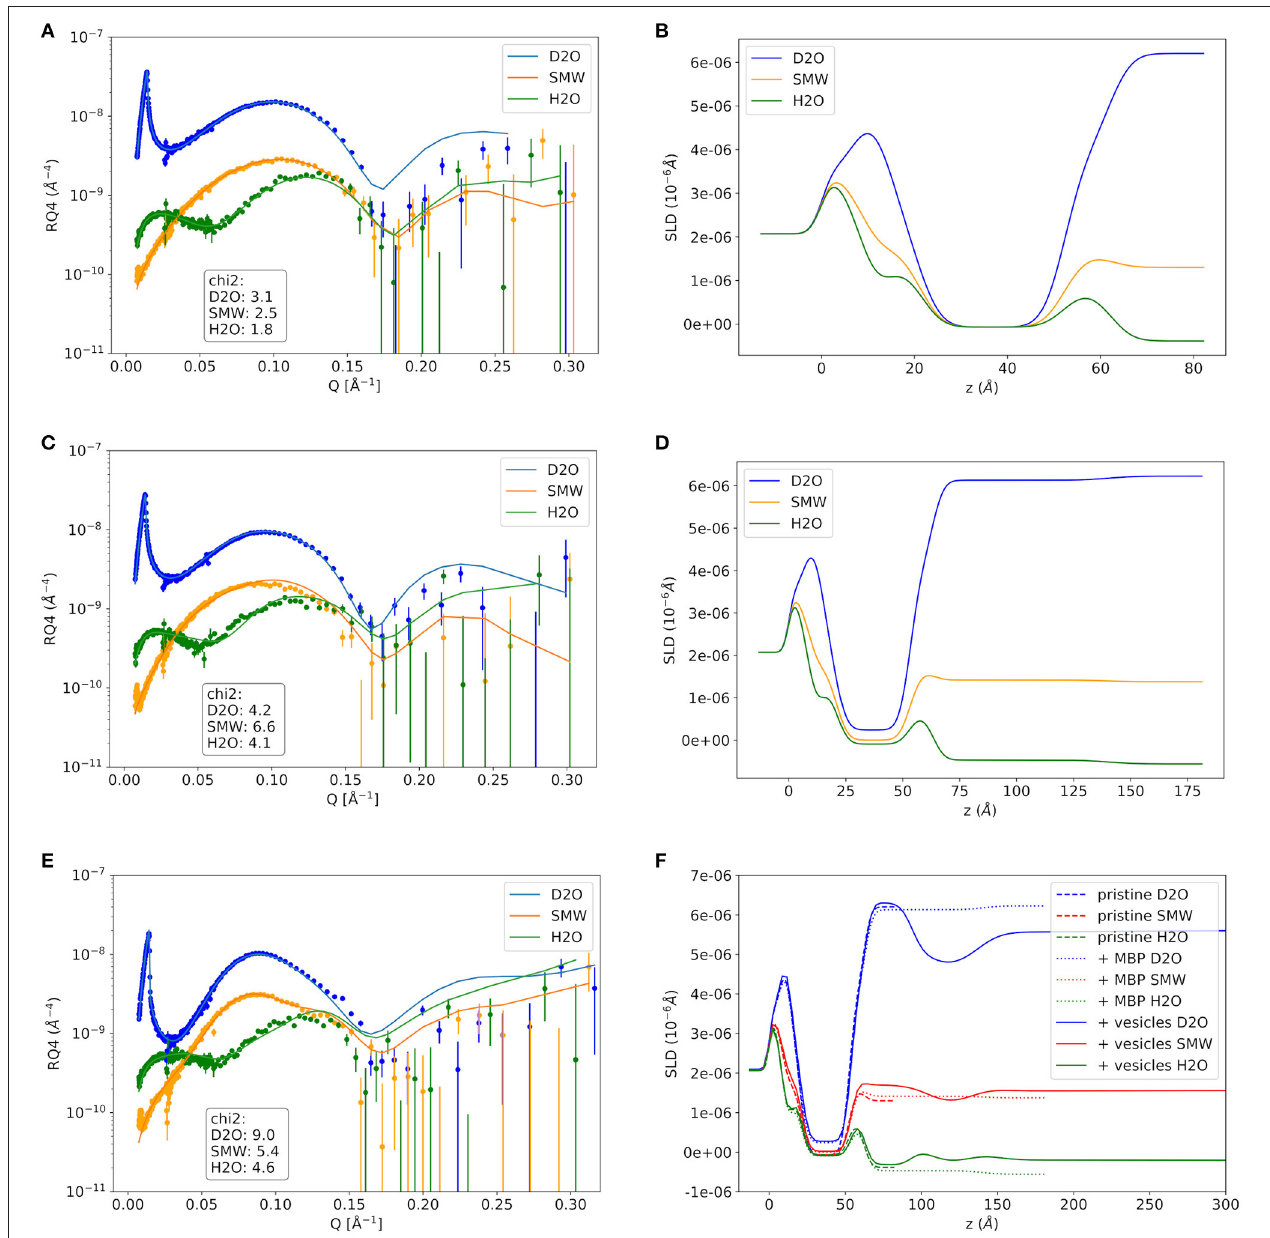
FIGURE 3 | Neutron reflectivity curves and respective SLD profiles of the Native01 sample. (A,B) The pure native membrane without MBP, (C,D) the supported membrane with MBP protein layer on top that was formed by addition of protein solution with 0.1 mg/ml MBP, and the double-membrane structure with dense intramembrane MBP-layer that was formed after vesicle adhesion in (E,F) . In (F) the SLD profiles of the pristine membrane and the MBP coated membrane are shown as comparison. NR data was measured on the D17 neutron